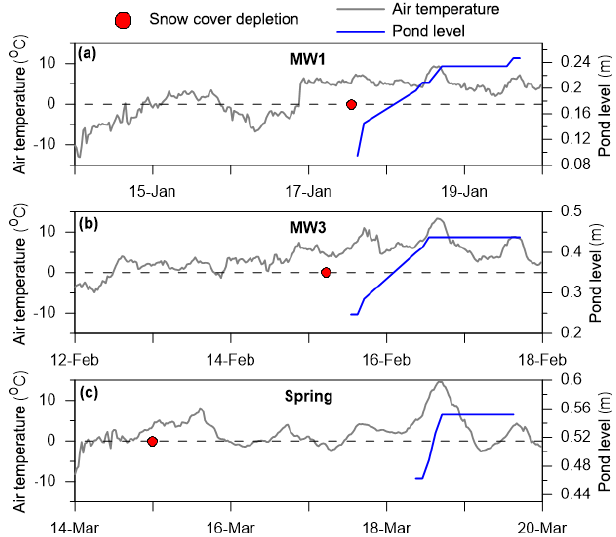
Figure 6. Dates of snow cover depletion and the timing of pond level increases in depression W at Triple G. The red circles indicate the date by which most snow cover depletion occurred. Grey lines show the average hourly air temperature, and blue lines show the pond